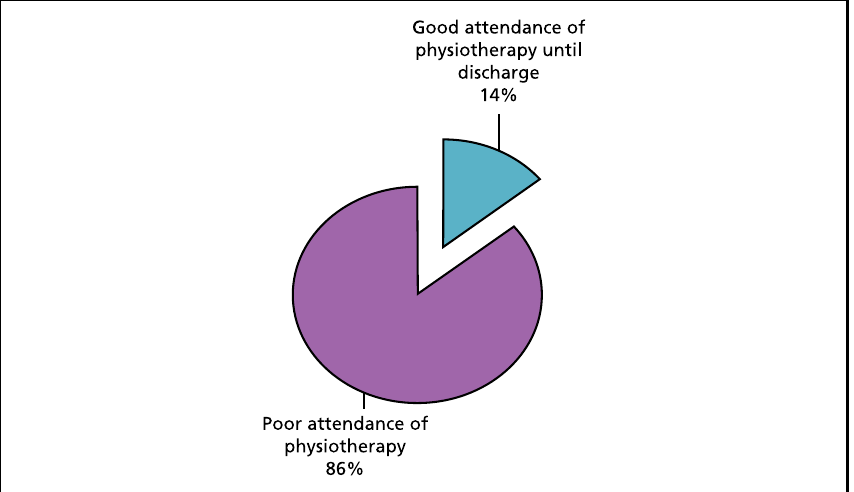
Figure 2: adherence to physiotherapy until discharge by patients with a stroke (n=85).